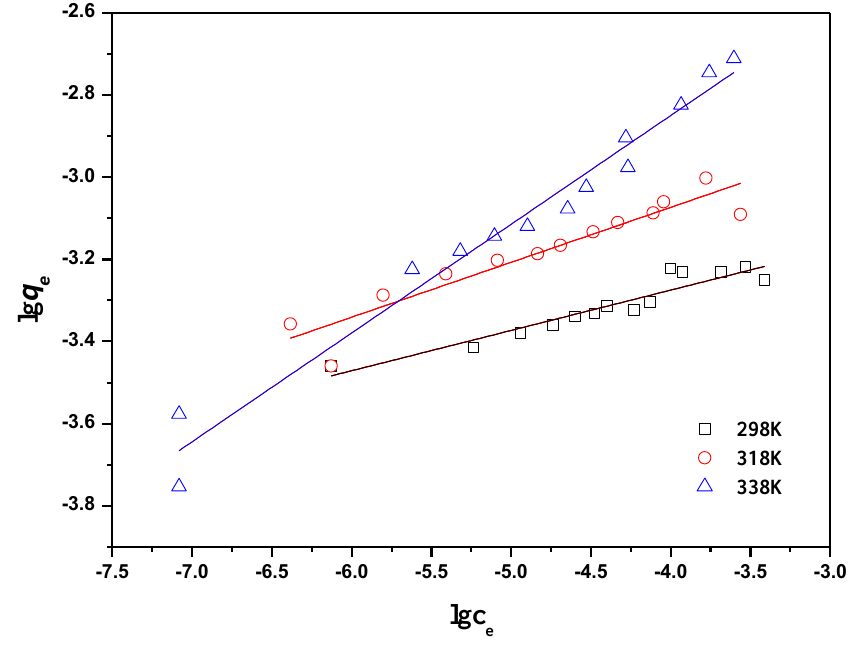
Figure 9. Freundlich model of Th(IV) adsorption onto oMWCNTs, m/V =0.1 g/L, pH = 3.20 ± 0.05, I = 0.01 mol/L NaNO , C[Th 4+ ] initial = 8.86 × 10 −5 3